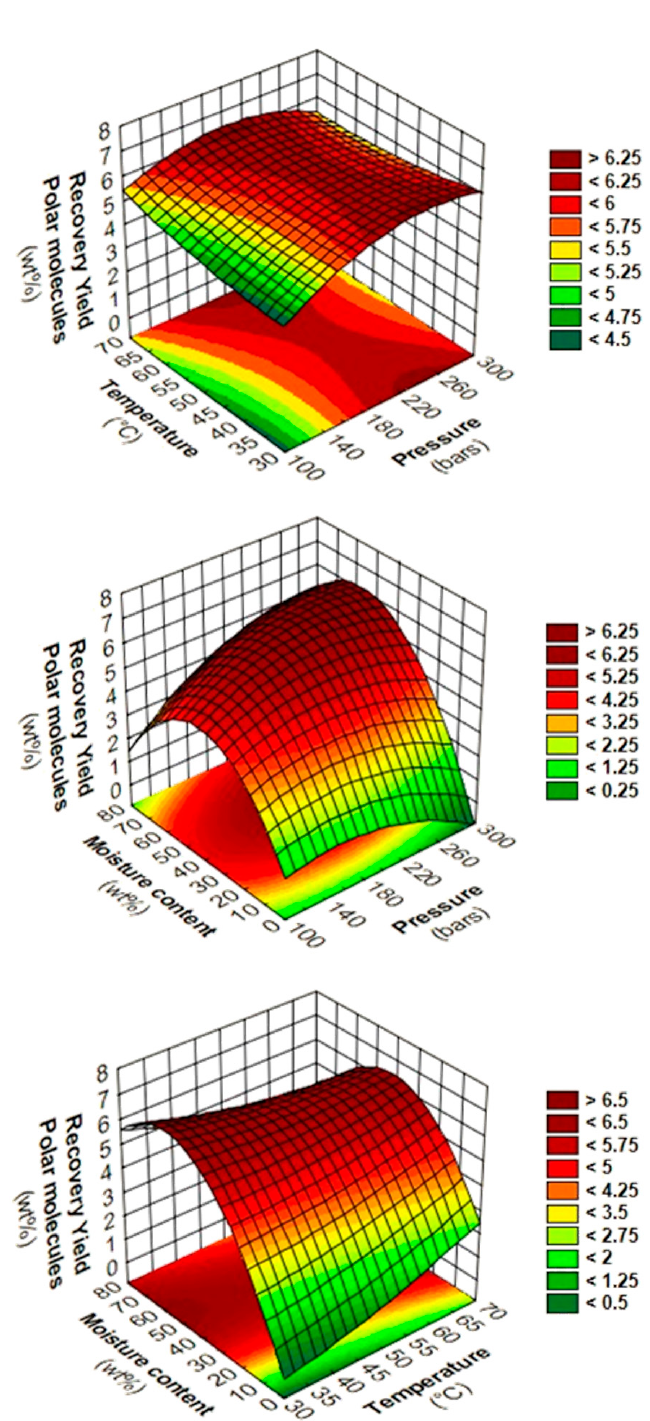
Figure 2. Response surfaces and contour plots of two-way interactions between pressure/temperature ( top ) at 40 wt% moisture content, pressure/moisture content at 50 °C ( middle ), and temperature/moisture content at 200 bars ( bottom ) for RYP of SC-CO 2 extraction from SCG.